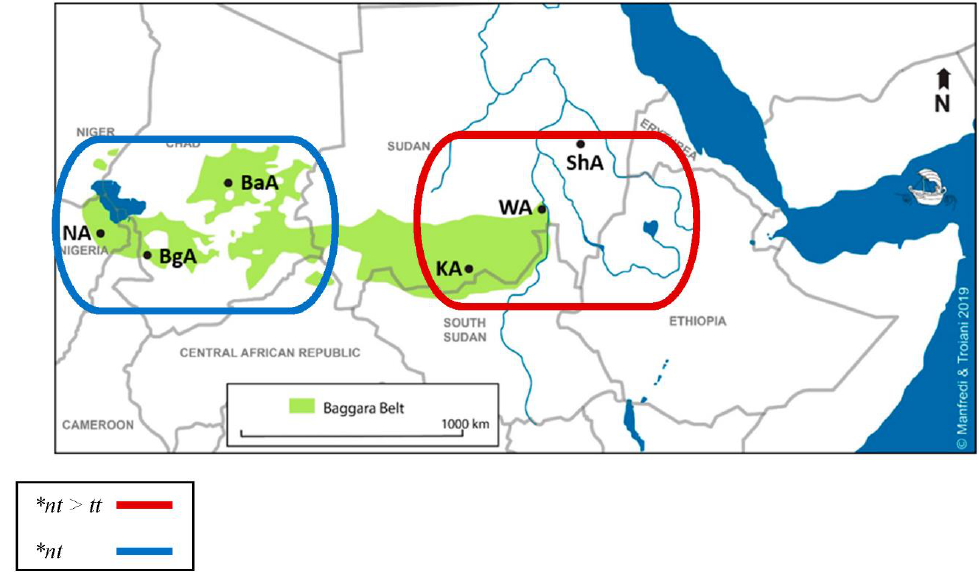
Figure 5. * nt > tt in 2nd person independent pronouns.